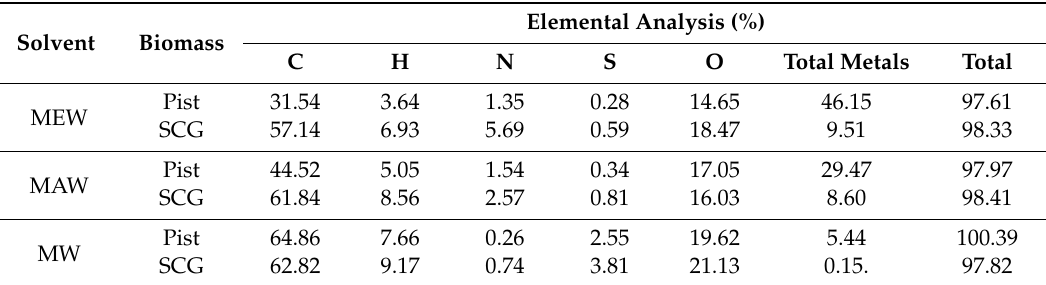
Table 3. Elemental analysis results performed to LEF samples. The “total metals” column is a sum of all the metals present in the respective sample obtained from ICP-OES, and the “total” column is the sum of the elemental analysis and the “total metals” column.